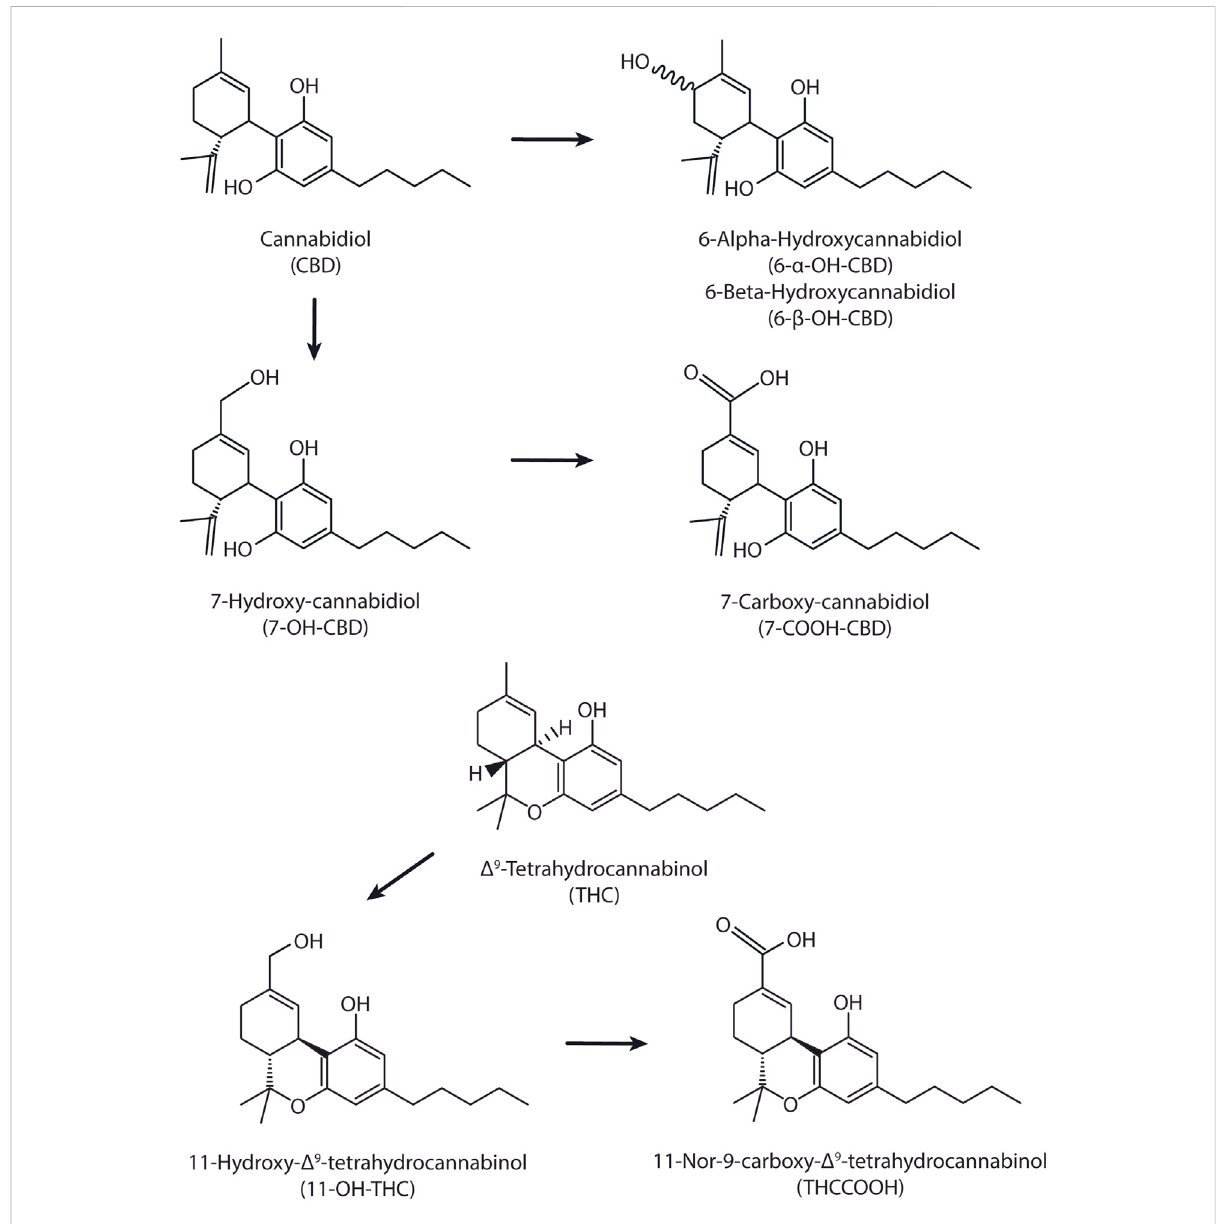
FIGURE 1 Chemical structures for CBD, THC, and their respective